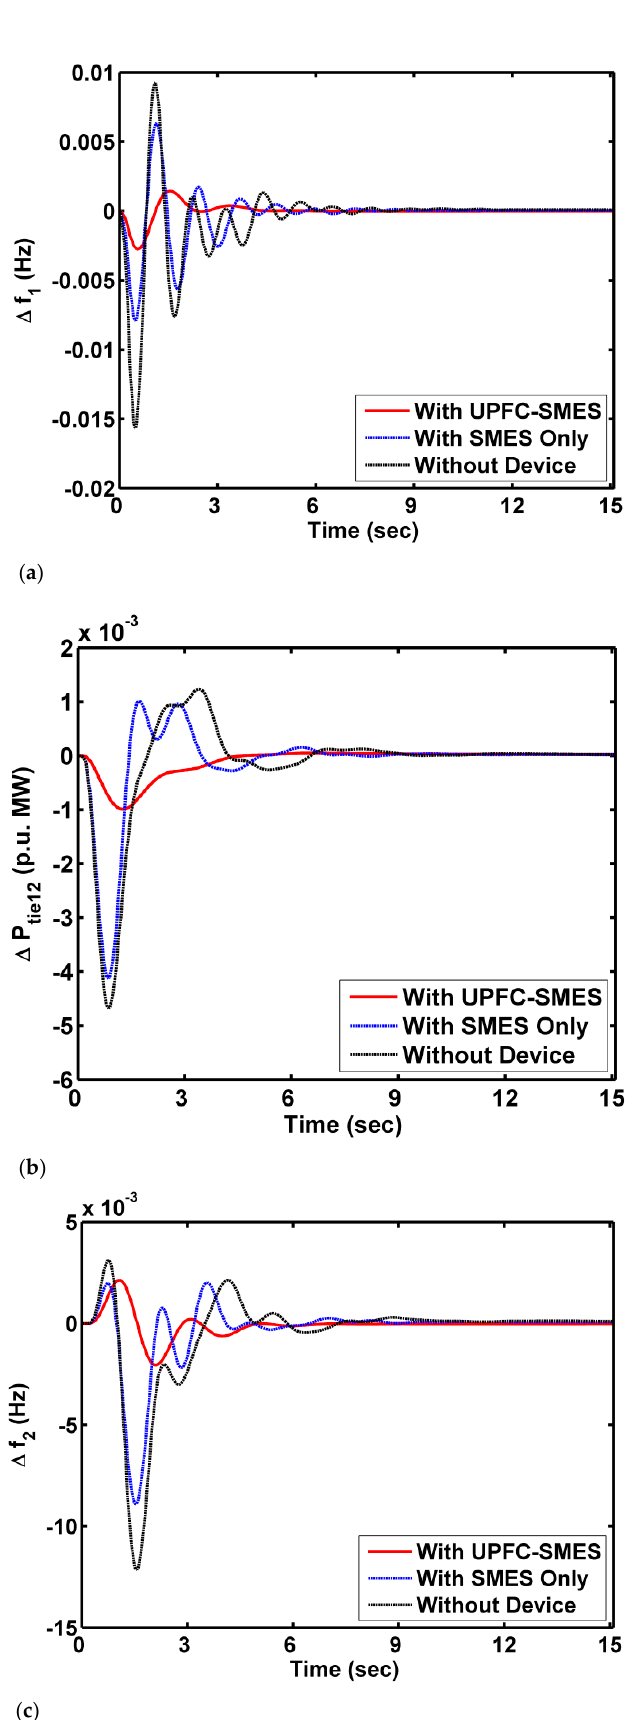
∆ f ∆ P tie 12 and ( c ) 1 ( b )